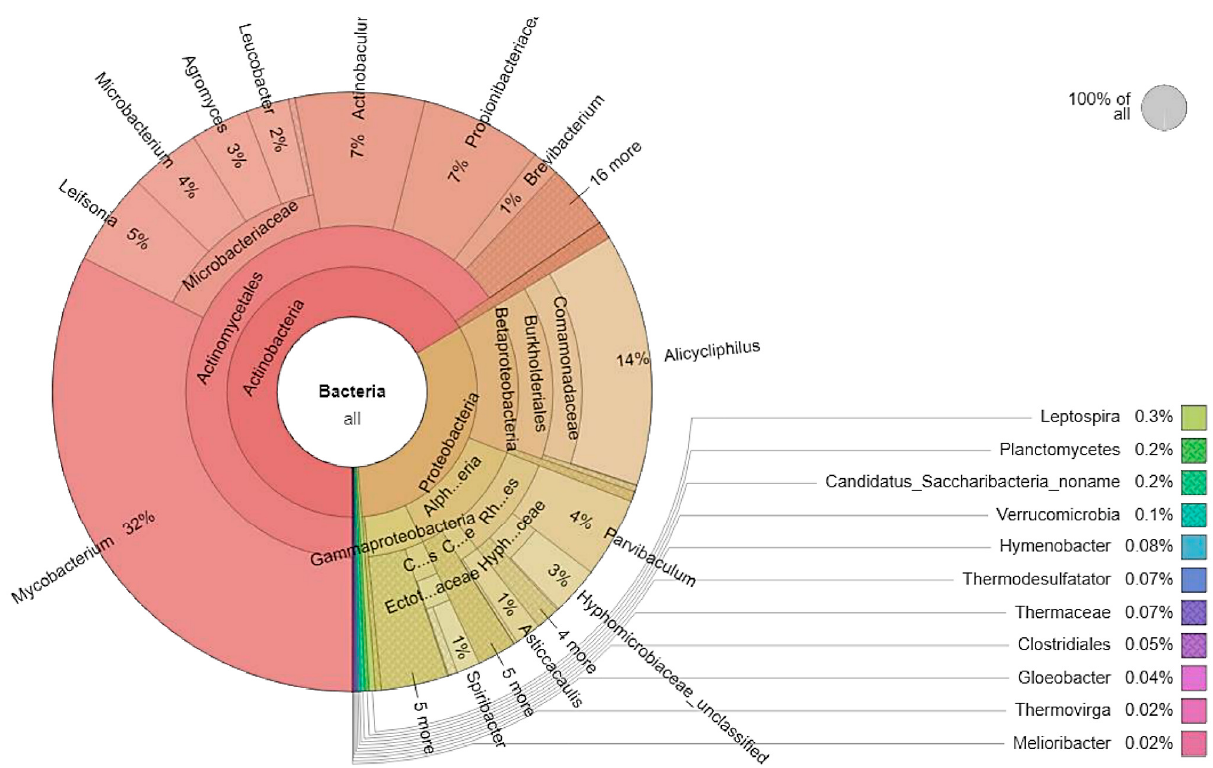
Figure 1. Taxonomic affiliation of micro-organisms in soil LF2.